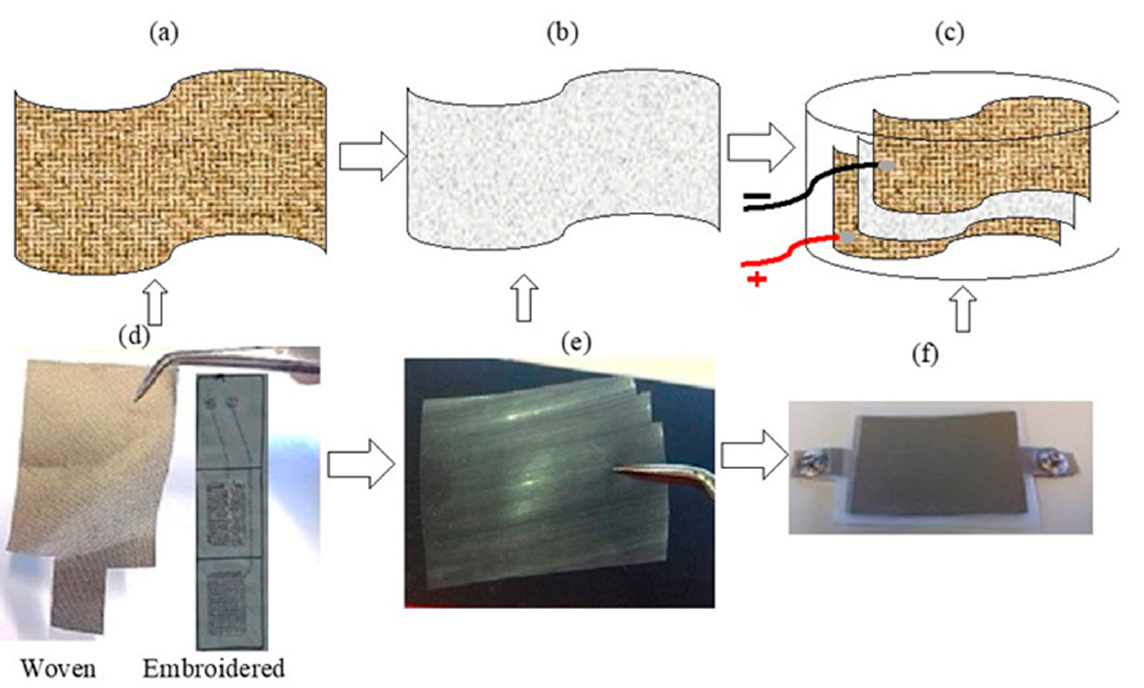
Figure 2. Fabrication process of the piezoelectric smart-textile sensor (PSTS) and harvester (PSTH), where ( a – c ) represent schematic diagrams of the conductive textile, polarized PVDF film, and a complete sensor, respectively; ( d – f ) show the real-world manufacturing steps of the PSTS and PSTH, respectively.